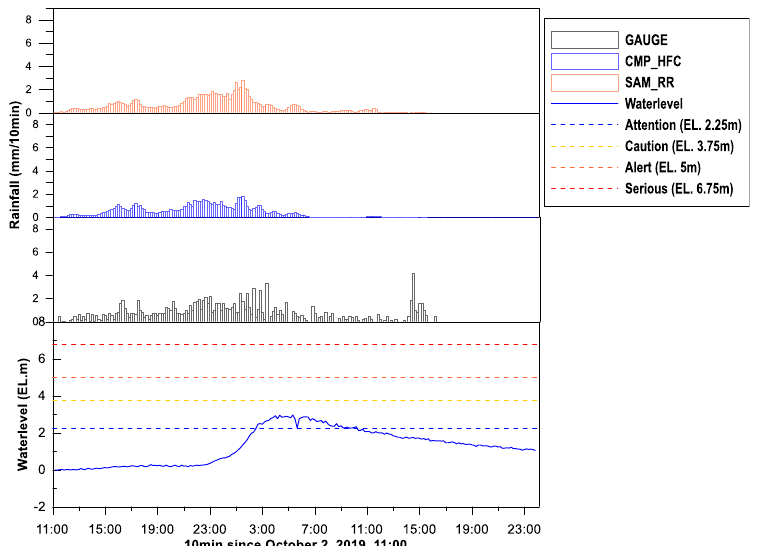
Figure 10. Observed water level and timeseries data of the mean real precipitation between 2 and 3 October 2019.